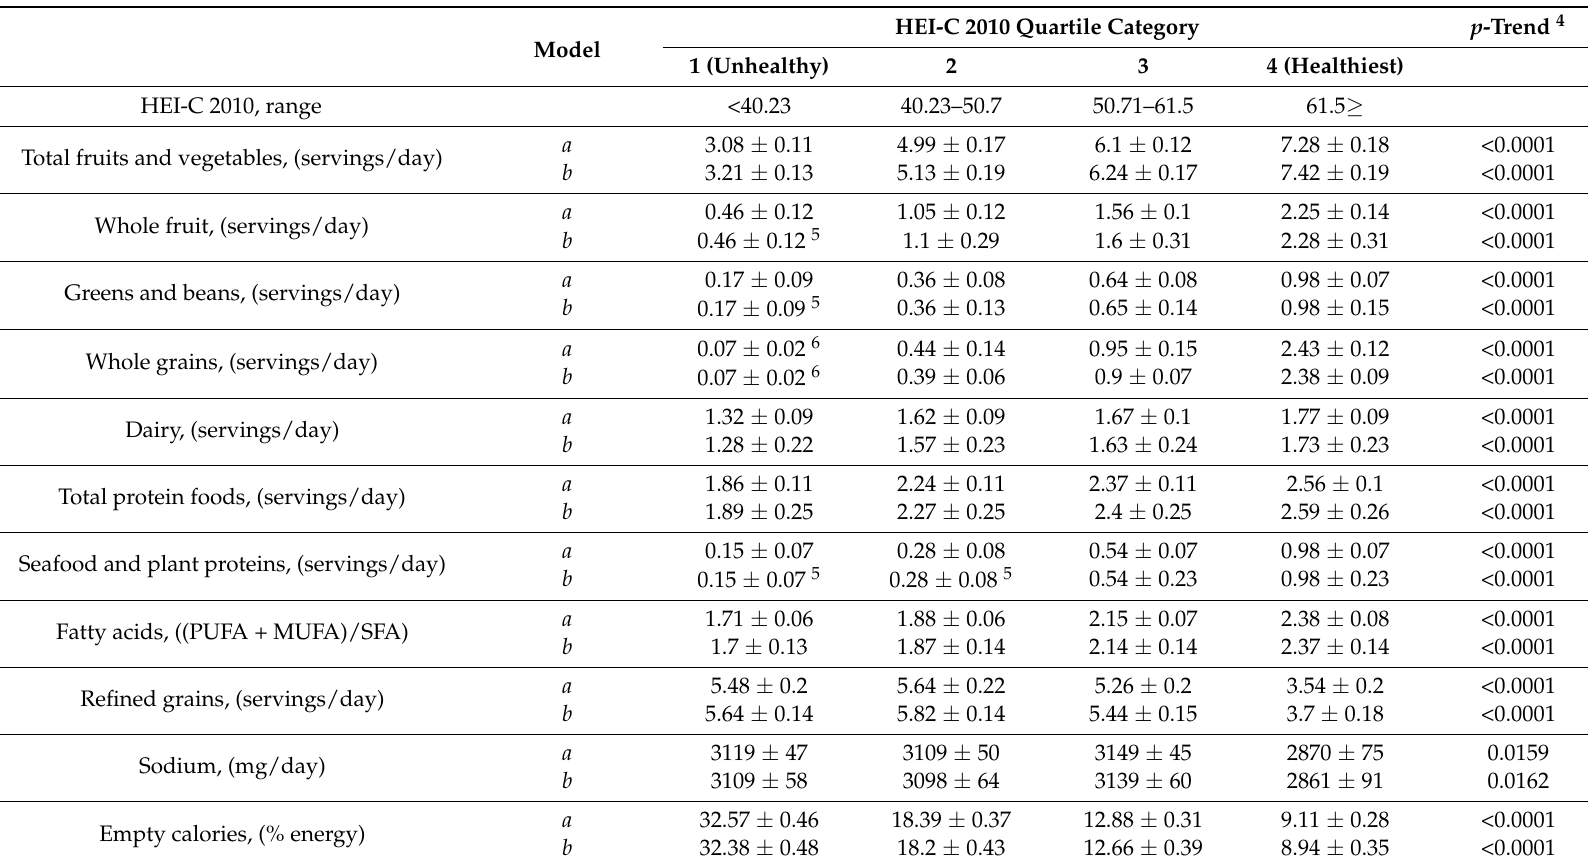
Table 3. Weighted mean of HEI-C 2010 components presented by quartile category of the HEI-C 2010 among Canadian adults ( n = 12,805) 1–3